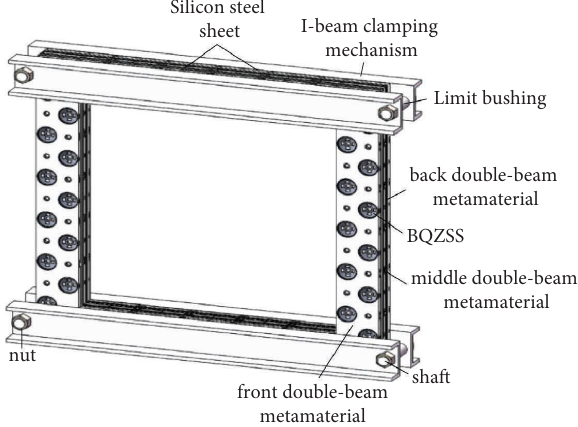
Figure 1: Transformer iron core with silicon steel sheets and double-beam